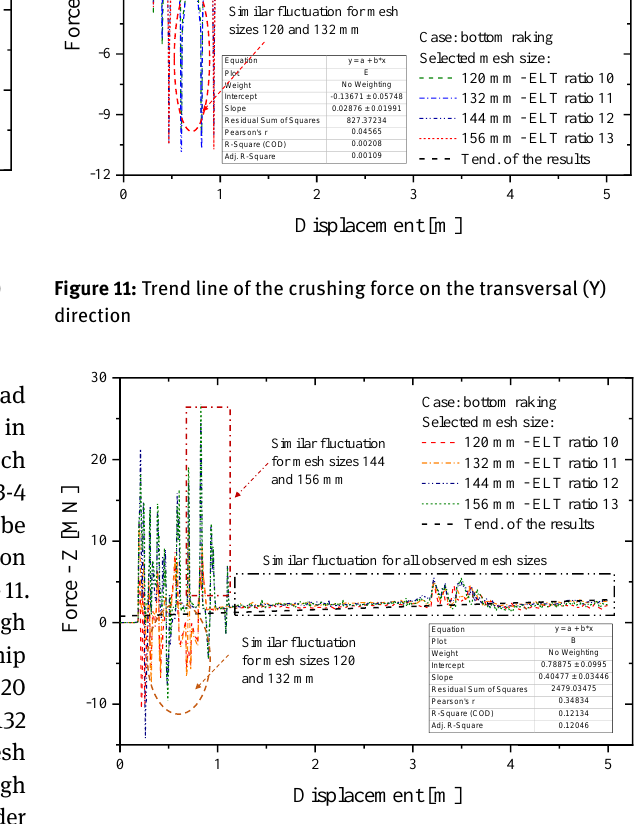
Figure 12. Trend line of the crushing force on the vertical (Z) direction. Figure 12: Trend line of the crushing force on the vertical (Z) direc-